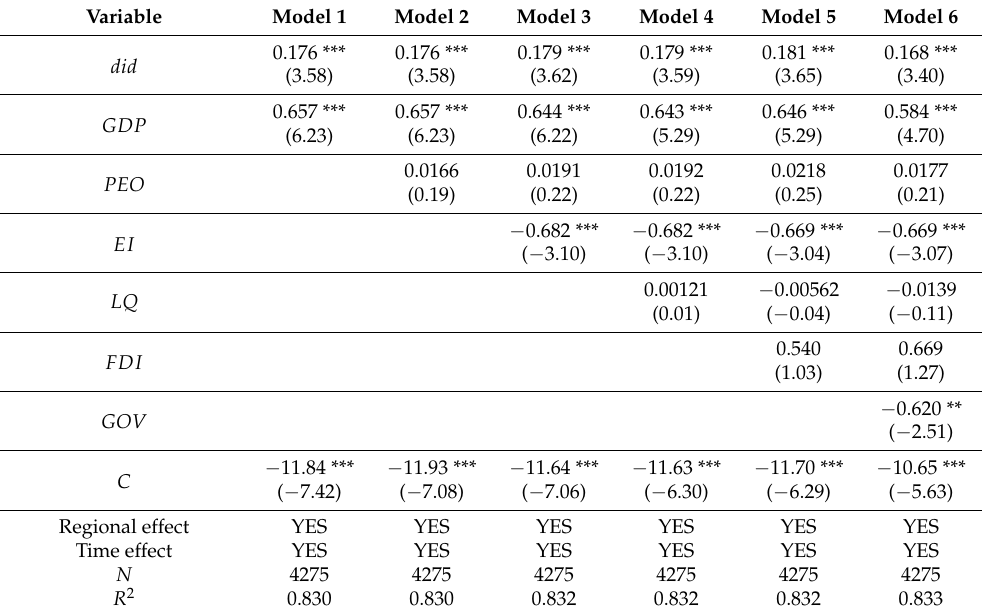
Table 3. Baseline regression